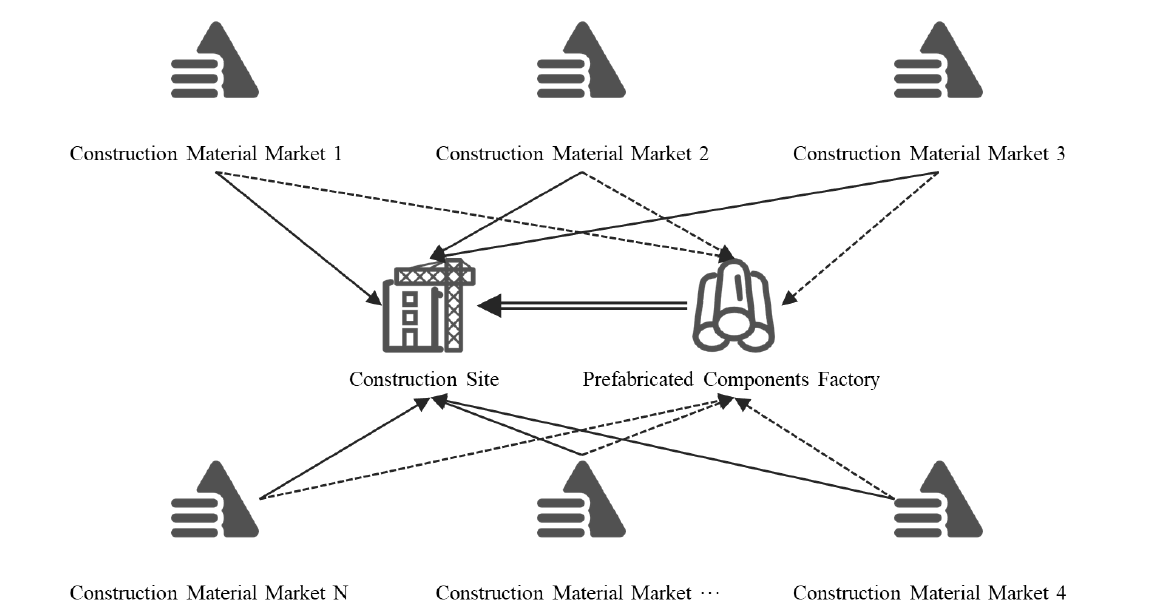
Figure 2. The Space Boundary of the